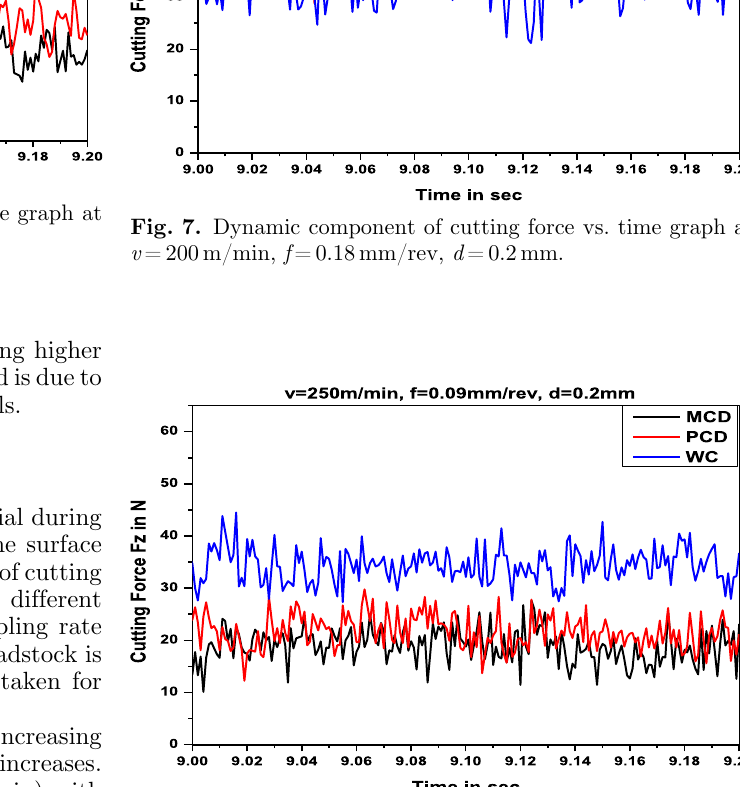
Fig. 8. Dynamic component of cutting force vs. time graph at v = 250m/min, f =0.09 mm/rev, d =